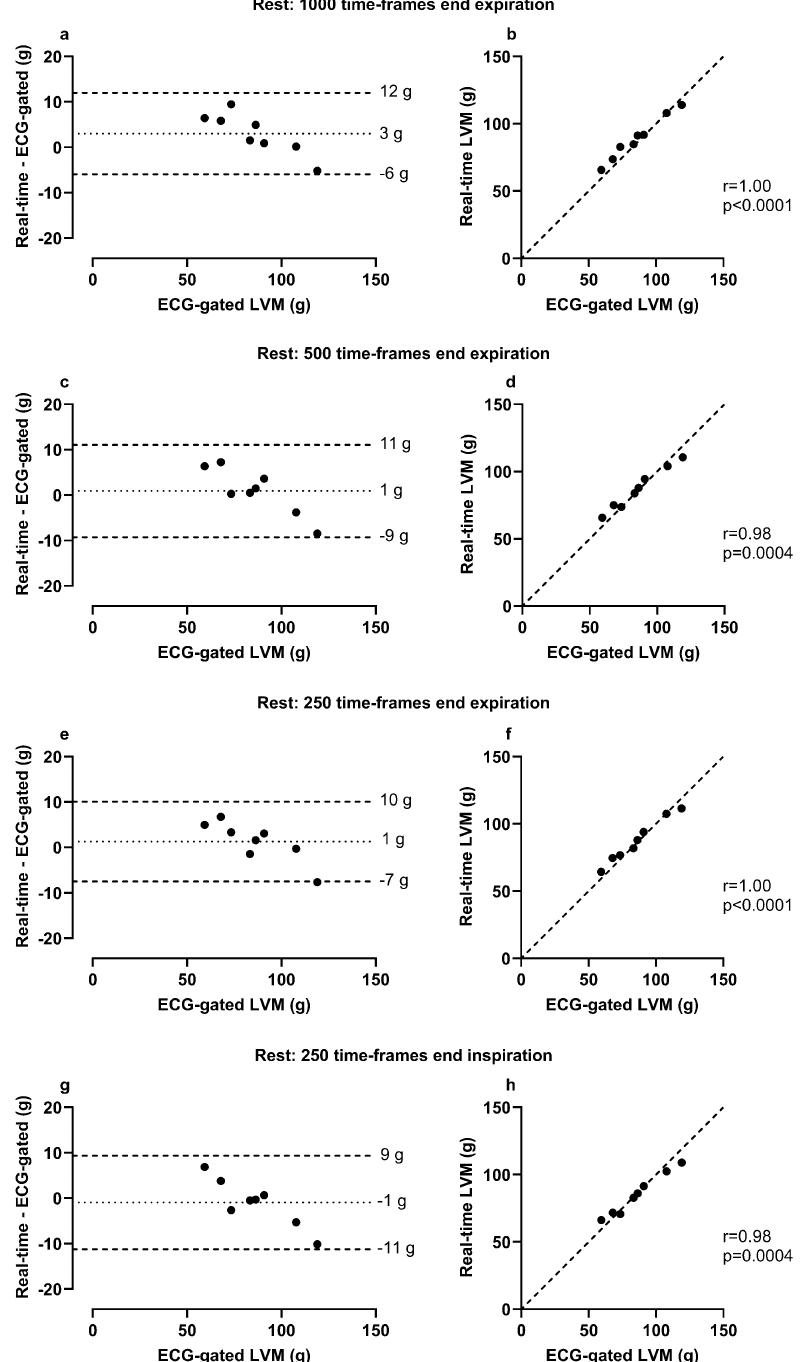
Figure 3. Agreement of left ventricular mass (LVM) measurements in real-time (RT) images versus ECG-gated images in healthy volunteers. Panels a–h show measurements made at rest, panels i–l during exercise and panels m–n regardless of respiratory state at rest. Note that for all panels, ECG-gated LVM was measured at rest. RT measurements were made at rest and end expiration unless otherwise specified . Bias was low and correlation high in all measurements in end-respiratory states, however one extreme value was seen in the two exercise measurements (i, k). In both cases, one basal slice was missing in one RT image stack during exercise. Bias was high in first heart beat measurements made regardless of respiratory state. For Bland–Altman plots the dotted line represents bias, defined as the mean difference between real-time and ECG-gated measurements and the dashed lines represent the upper and lower 95% limits of agreement (bias ± 1.96 SD of the difference). In the scatter plots the dashed line represents a line of